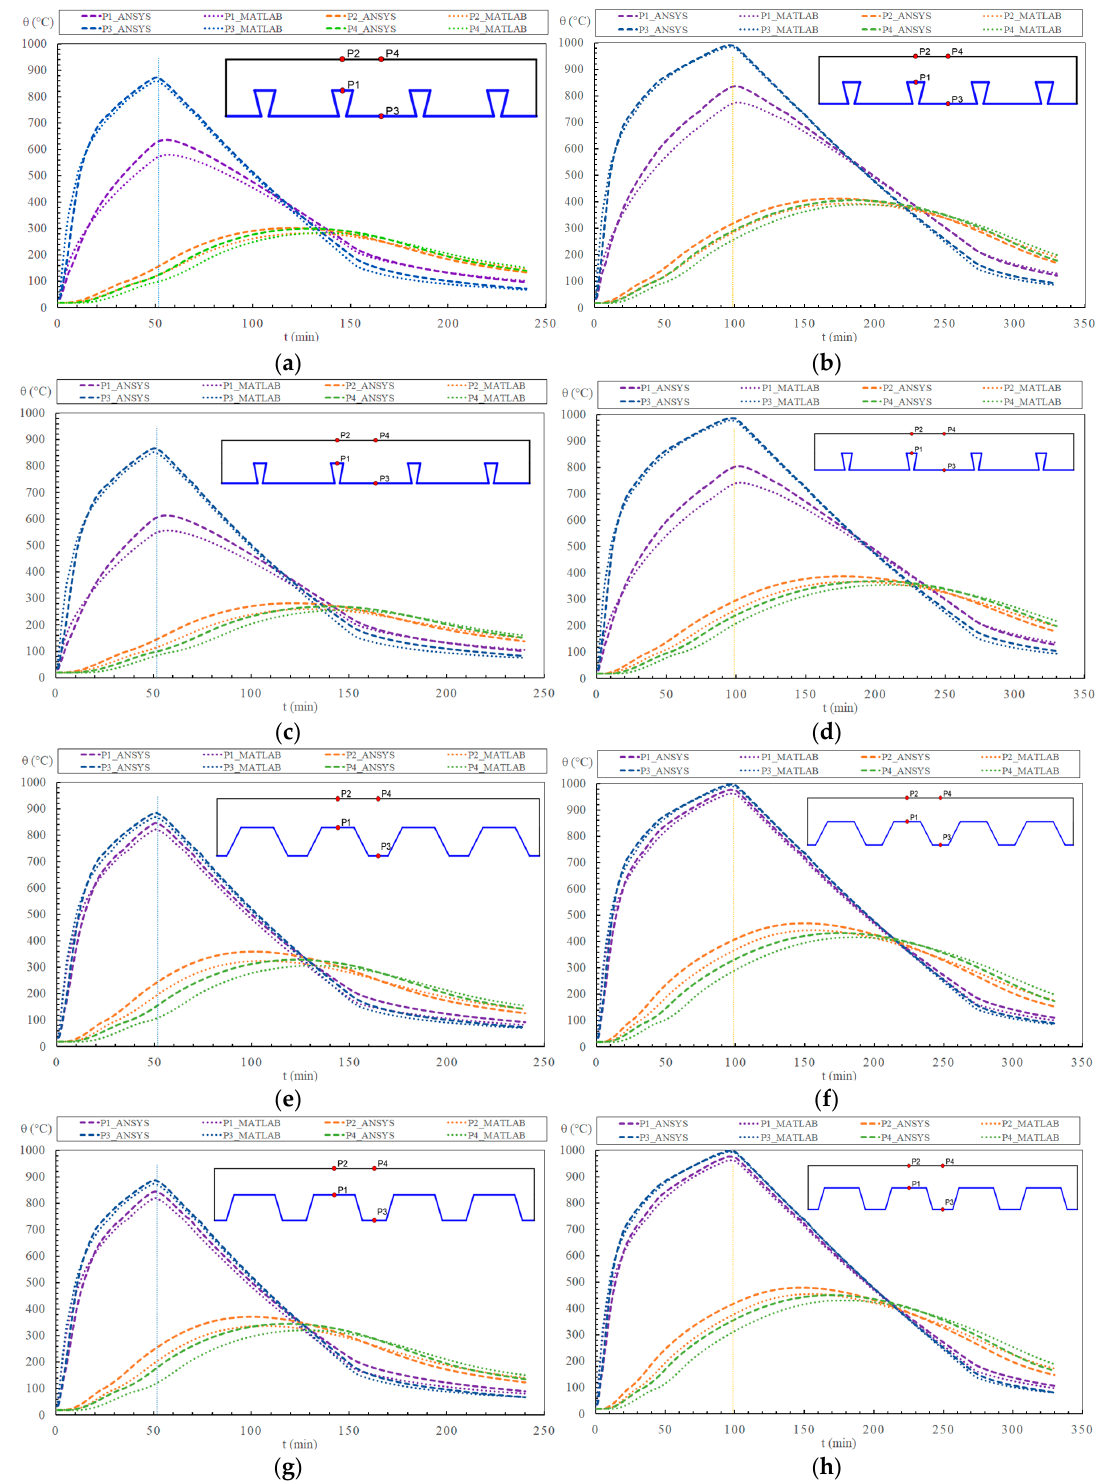
Figure 8. Temperature history in key points of the composite slabs under parametric fire curves for the same h 1 = 60 mm: ( a ) Multideck 50 under parametric fire 2; ( b ) Multideck 50 under parametric fire 3; ( c ) Bondeck under parametric fire 2; ( d ) Bondeck under parametric fire 3; ( e ) Polideck 59S under parametric fire 2; ( f ) Polideck 59S under parametric fire 3; ( g ) Confraplus 60 under parametric fire 2; ( h ) Confraplus 60 under parametric fire 3.